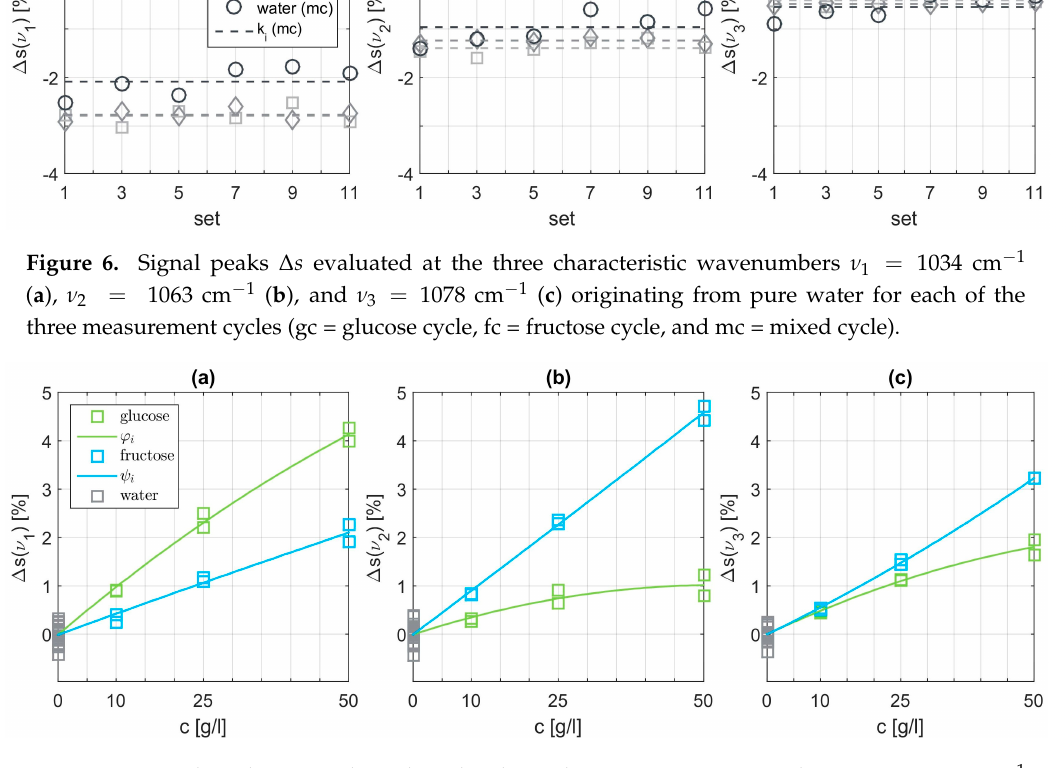
Figure 7. Signal peaks ∆ s evaluated at the three characteristic wavenumbers ν 1 = 1034 cm − 1 ( a ), ν 2 = 1063 cm − 1 . ( b ), and ν 3 = 1078 cm − 1 ( c ) originating from pure glucose or pure fructose, respectively. The content of pure water is already subtracted using the corresponding average value. The displayed basis functions ϕ i and ψ i are quadratic polynomials.